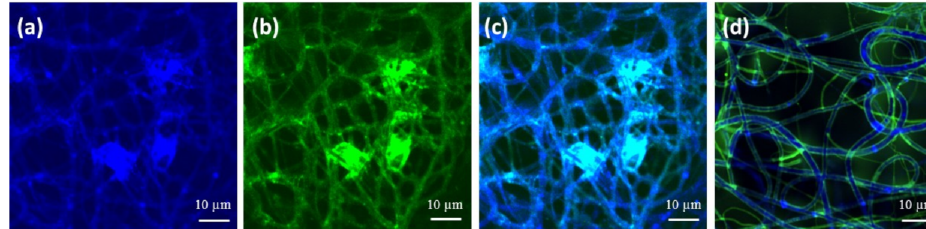
Figure 3. Confocal microscopy images of a dry mesh of HA + FmocFRGD/PCL core/shell fibers. ( a ) The PCL component (blue). ( b ) The HA + FmocFRGD component (green). ( c ) The overlay of the two components. ( d ) The same sample after immersion in water, displaying the transition of the HA + FmocFRGD (green) to the surface of the fibers, leaving the PCL (blue) at the center of the